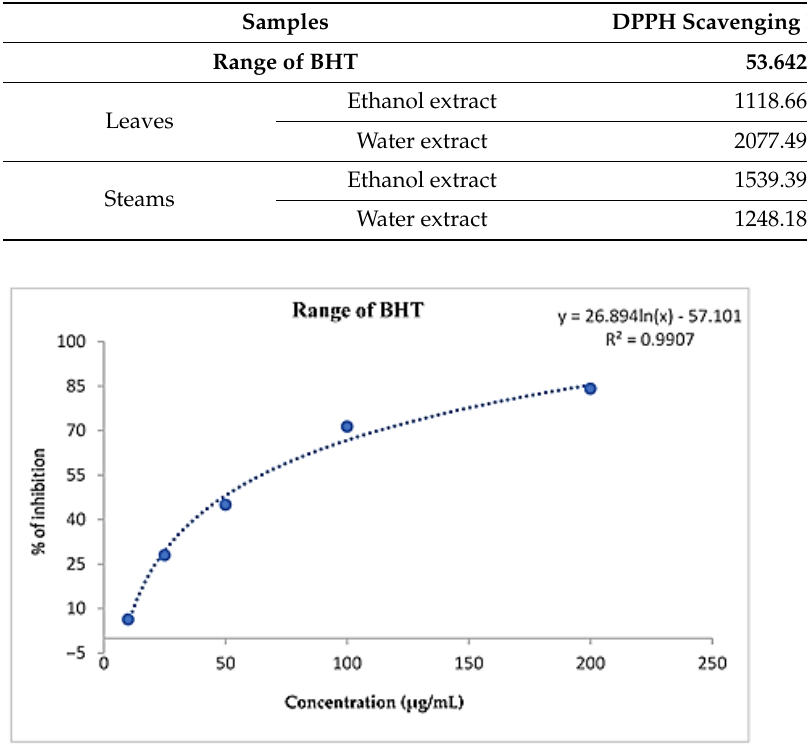
Figure 3. DPPH free radical scavenging activity curves for butylated hydroxytoluene (BHT). Table 5. Percentage of DPPH free radical inhibition of water and ethanol extracts of leaves and stems.